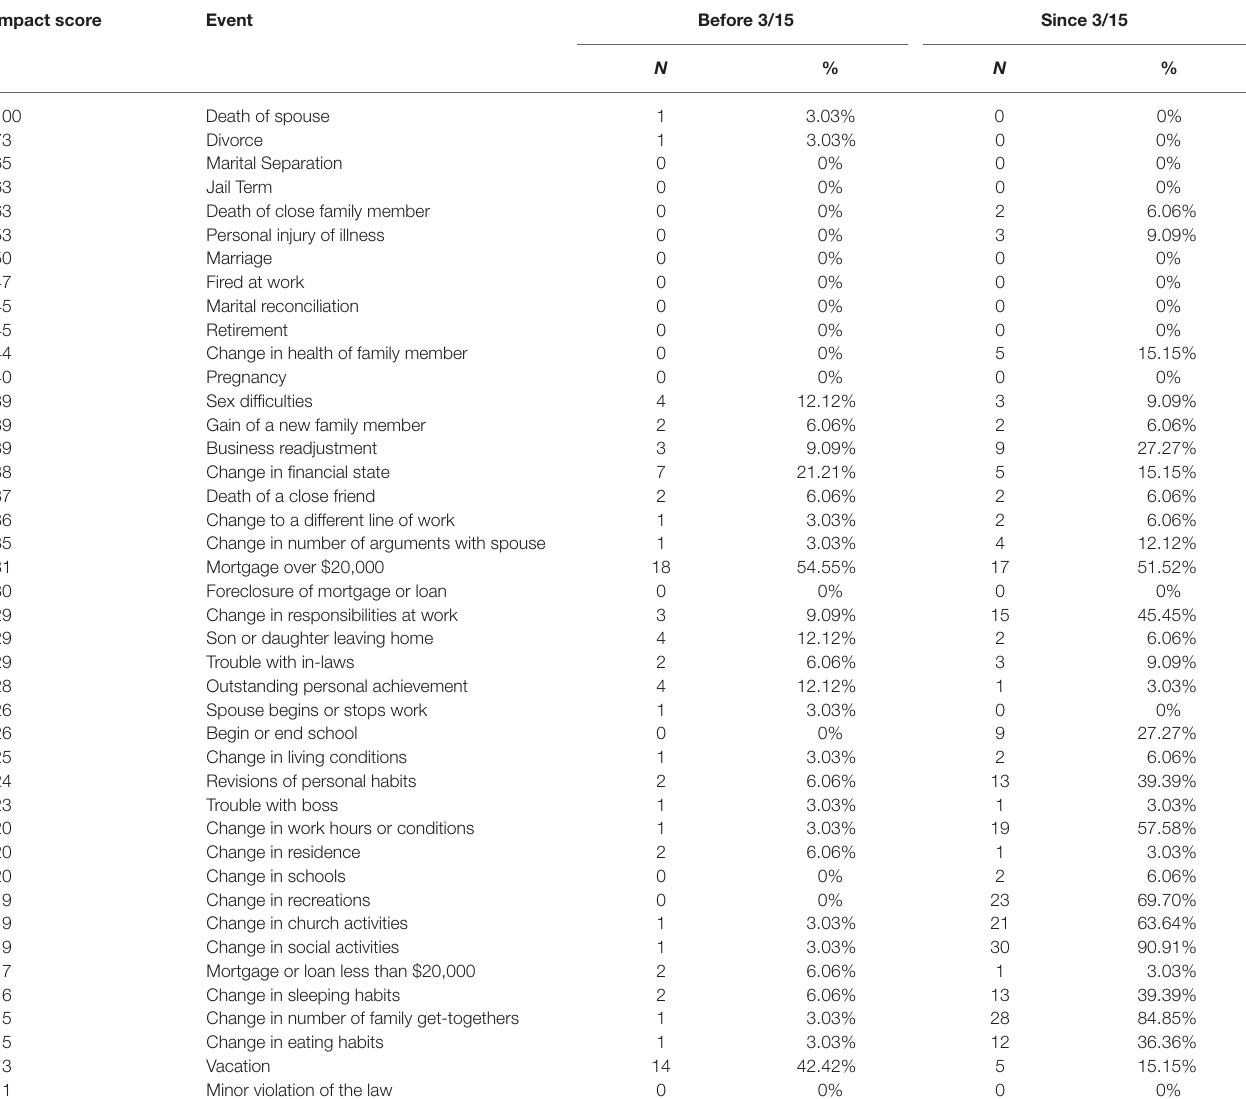
TABLE 1 | Number of participants and percentage of sample who endorsed each stressor from the Social Readjustment Rating Scale (SRRS) before and since local lockdowns began, around March 15, 2020, along with associated impact scores for each stressor. Impact score